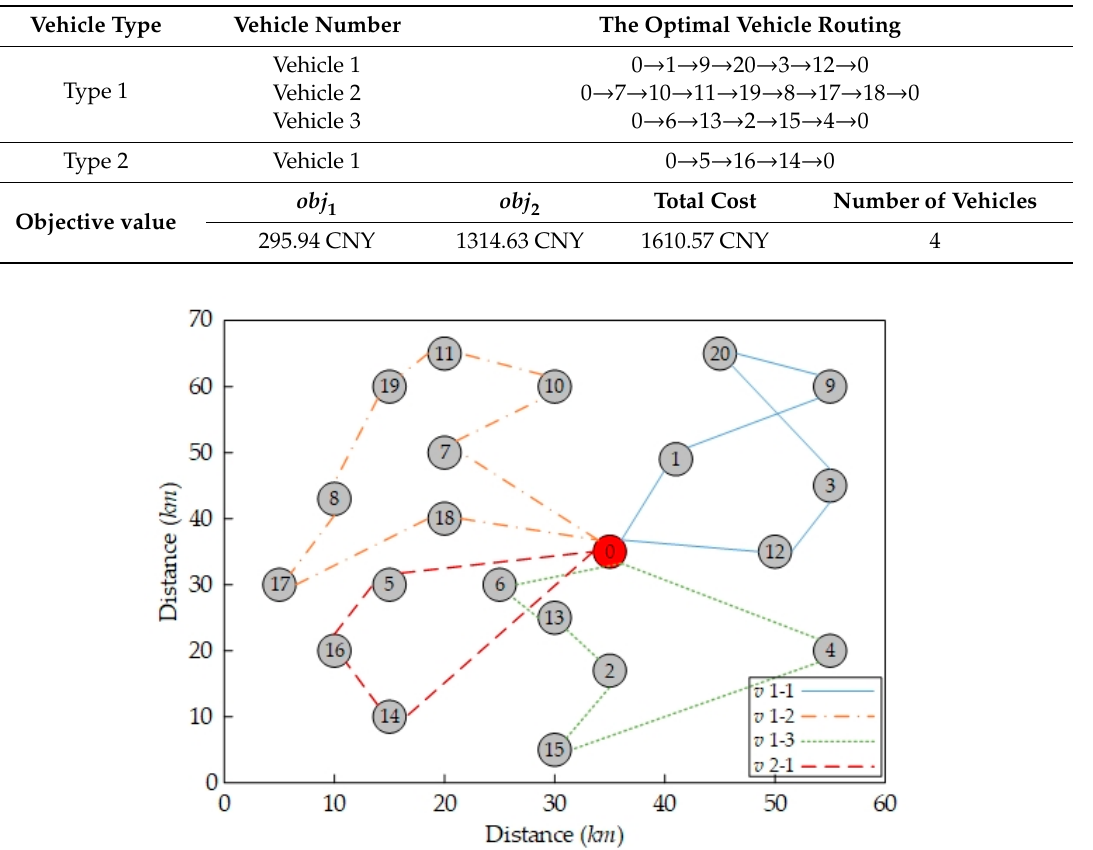
Table 5. Optimal tomato picking and distribution scheduling.